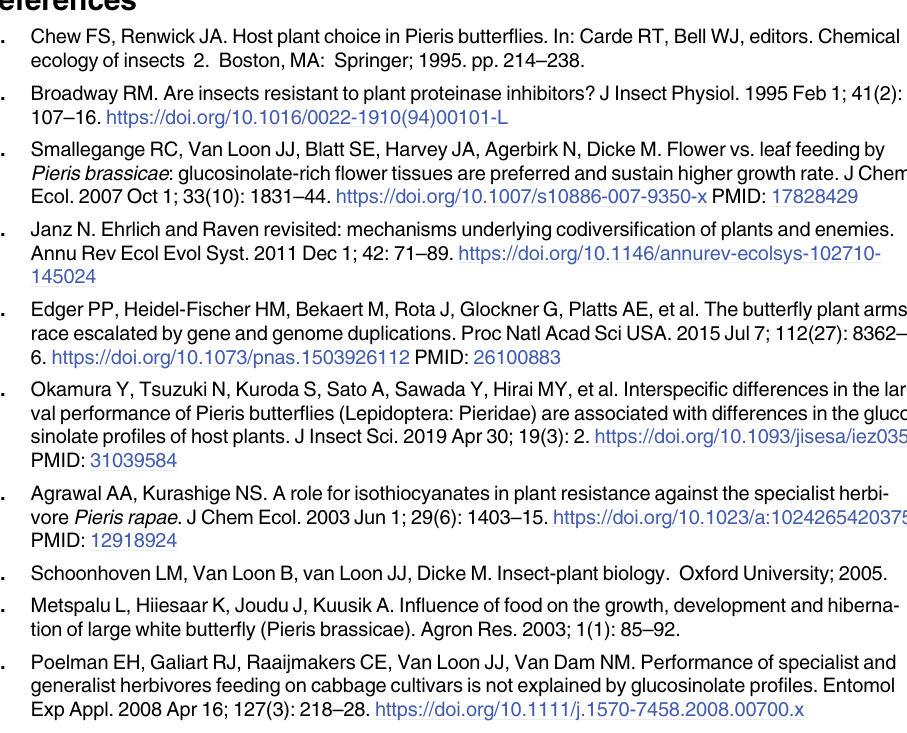
S1 Table. Sequences of putative serine proteases used for Fig 5. Sequences from this study are shown in